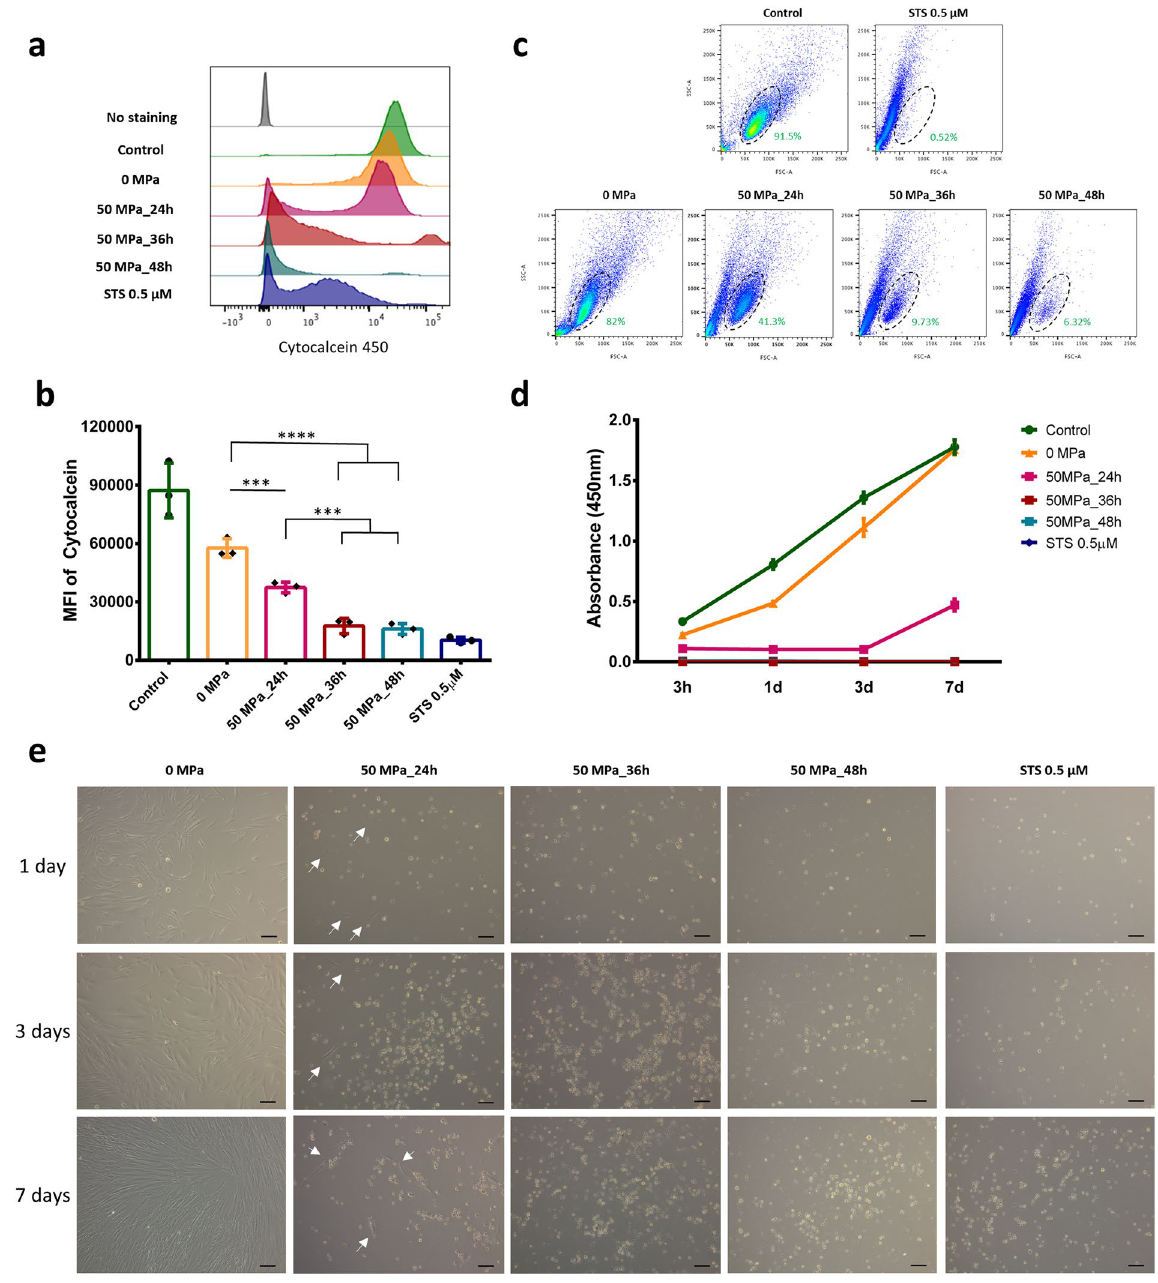
Figure 5. Viability and proliferation of HHP-treated cells. ( a ) Representative histograms of Cytocalcein 450 fluorescence (viability stained) among groups, with cells exposed to 50 MPa for 36 and 48 h showing negative expression, similar to STS treatment, while those pressurized for 24 h show bimodal distribution. ( b ) The comparison diagram shows a significant reduction in the Cytocalcein MFI between the 0 MPa group and the group treated with 50 MPa for 24, 36 or 48 h (n = 3). ( c ) A flow cytometry analysis showing two distinct cell populations depending on the cell size (FSC) and granularity (SSC). The oval area in the control group indicates normal viable cells, which are present in the positive control (STS) group at only 0.52%. That number in the 0 MPa group is around 82% while viable cells account for around 41.3% after being pressurized at 50 MPa for 24 h and 9.73% and 6.32% after 36 and 48 h, respectively. Data are representative of at least three independent experiments. ( d ) Absorbance at 450 nm in the WST-8 assay shows the proliferation of control, untreated, HHP- treated and STS-treated cells after 7 days of seeding culture. Data are representative of at least two independent experiments, n = 7 for each time point. ( e ) Inverted light microscopy images of untreated, HHP-treated and STS-treated cells seeded onto a 24-well plate after 7 days of culture. The white arrow in the 50 MPa_24h group indicates viable cells. Magnification 10×, scale bar 100 μm. Data are representative of at least three independent